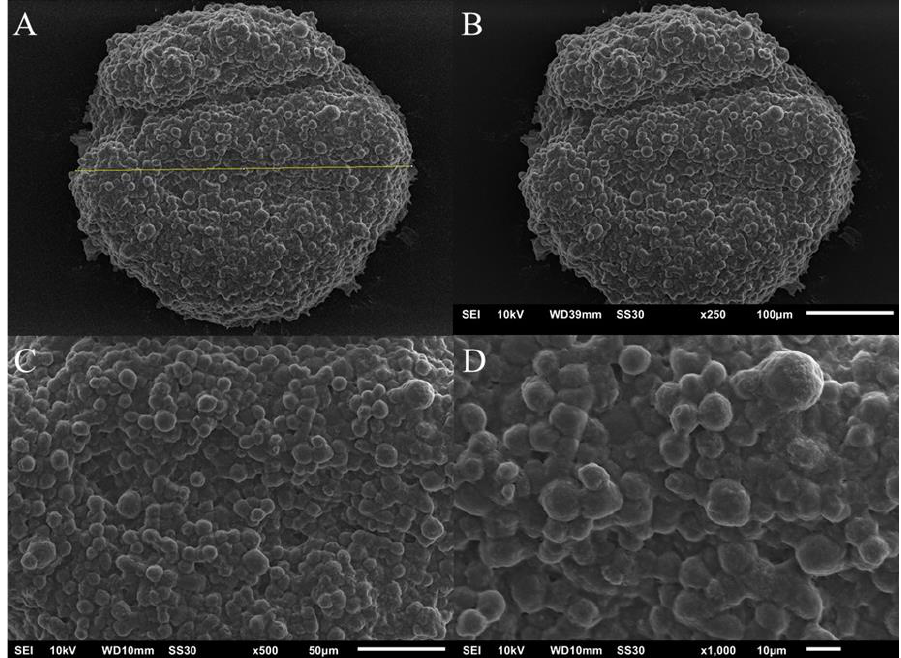
Figure 7. Image of the spheroid of the MRC-5 cell line. ( A ) — the yellow line indicates the diameter of the spheroid, measuring 389.33 µm; ( B ) — spheroid on ×250 objective; ( C ) — image on ×500 objective and ( D ) — ×1000 objective.